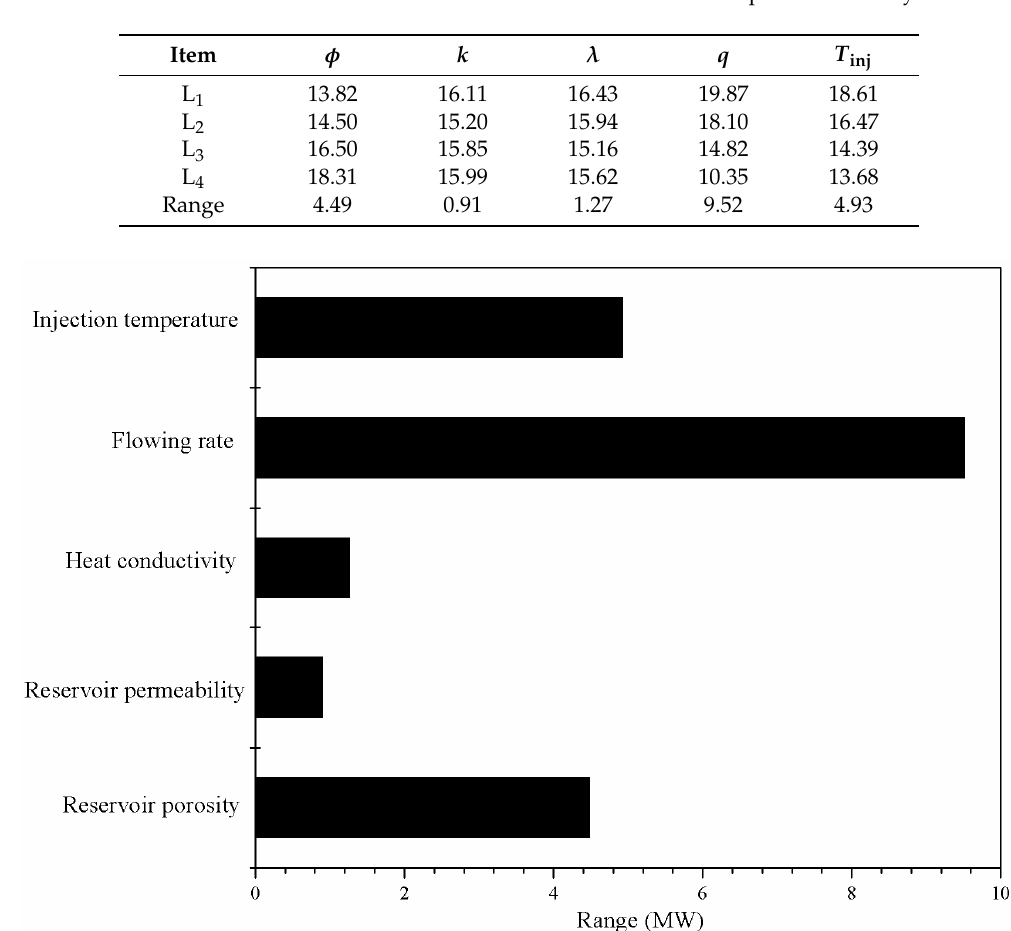
Figure 5. Ranking of the five conditions of the influential effects on the electric power.